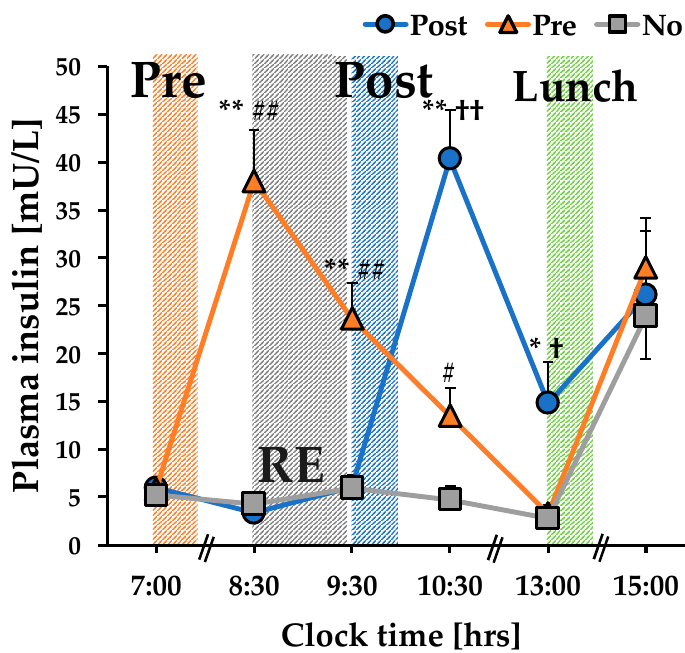
Figure 2. Time course change in plasma insulin. *; p = 0.043 Post vs. Pre, #; p = 0.023 Pre vs. No, † ; p = 0.015 Post vs. No, **; p = 0.001 Post vs. Pre, ## p = 0.001 Pre vs. No, †† ; p < 0.001 Post vs. No. RE: